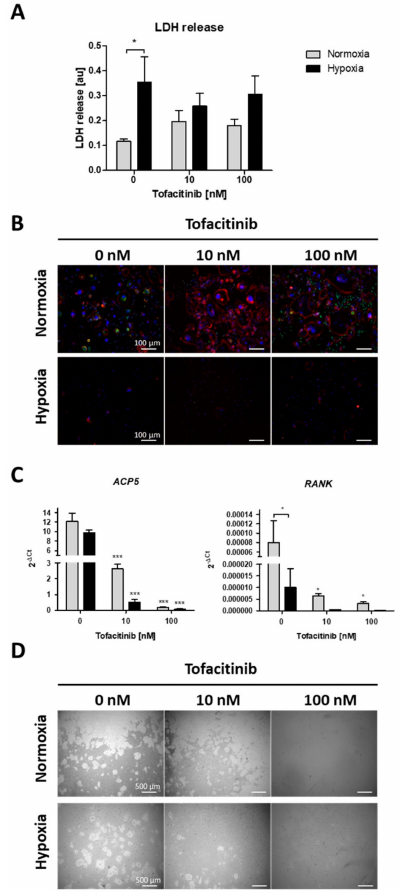
Figure 4. Tofacitinib reduces osteoclast di ff erentiation and activity under normoxic and hypoxic conditions. ( A ) LDH release after 1 week ( + 3 days) of osteoclast di ff erentiation and in the presence of 0, 10 and 100 nM tofacitinib under normoxic and hypoxic conditions (2% O 2 ). ( B ) Representative experiment of n = 4. Fluorescence images of di ff erentiated cells at day 21 in the presence of 0, 10 and 100 nM tofacitinib, stained with Phalloidin-TRITC for F-actin (red), DAPI (blue) and merged cathepsin K (green). Exemplary images representative for at least n = 4 in > 3 independent experiments (scale bars = 100 µ m). ( C ) Osteoclast marker gene expression for ACP5 and RANK after 1 week of osteoclast di ff erentiation ( n = 5; * p < 0.05, *** p < 0.001, two-way ANOVA with Bonferroni post hoc test; asterisks above columns indicate comparison to the respective untreated control = 0 nM tofacitinib). ( D ) Pit formation assay with osteoclasts di ff erentiated on Corning ® Osteo Assay after Von Kossa staining. Exemplary images representative for at least n = 4 in > 3 independent experiments (scale bars = 500 µ